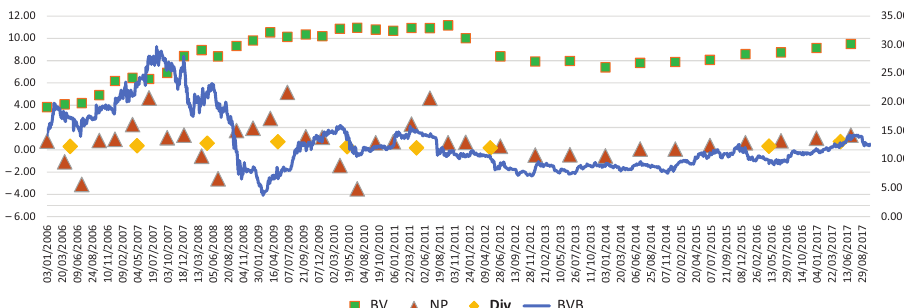
Figure 11. TA-FA correlation as a reference for information efficiency (source: own